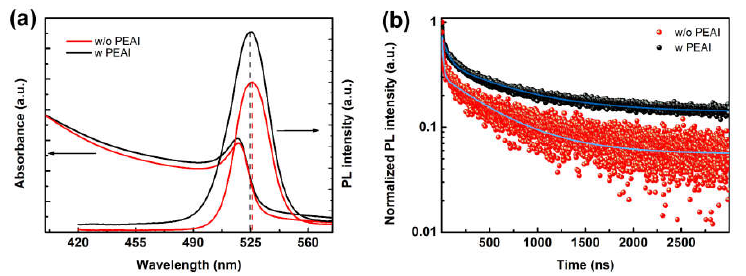
Figure 4. ( a ) UV–vis absorbance, steady PL, and ( b ) TRPL spectra of CsPbBr 3 films undoped and doped with 10 mg/mL PEAI without ETL or HTL. doped with 10 mg/mL PEAI without ETL or